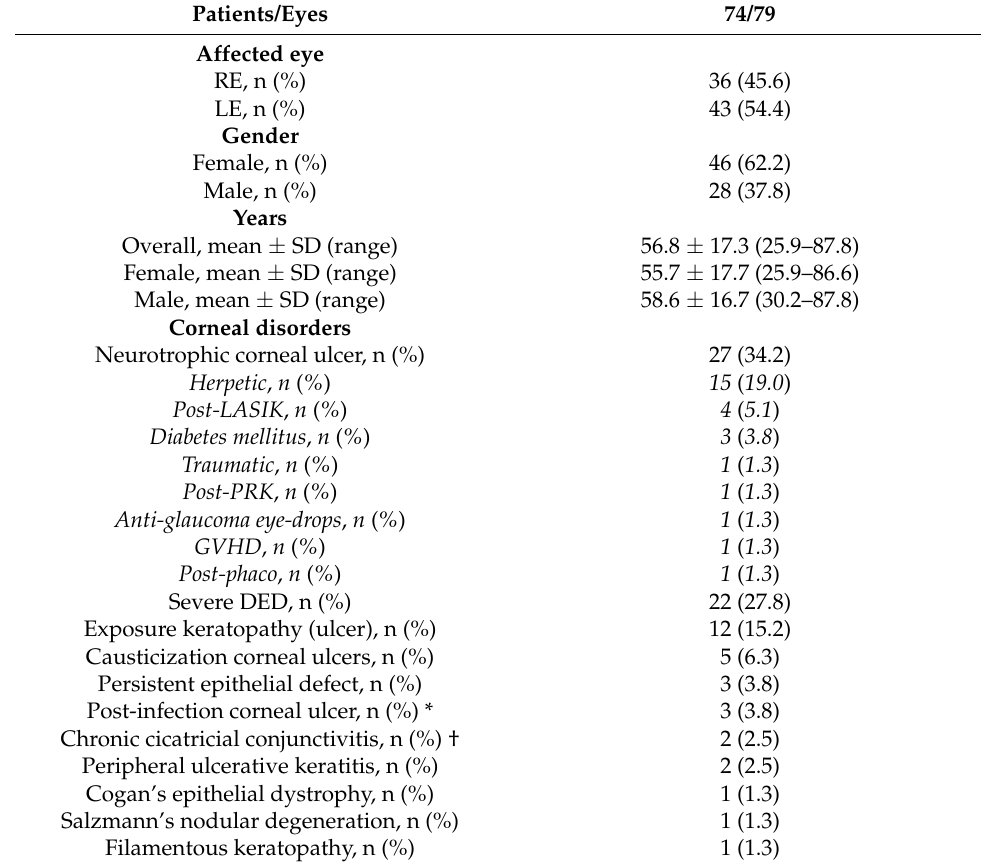
PRGF: Plasma Rich in Growth Factors, RGTA: ReGeneraTing Agent matrix, RE: Right, LE: Left eye, SD: Standard deviation, GVHD: Graft Versus Host Disease, DED: Dry-eye disease. * One eye with persistent ulcer after the resolution of the corneal abscess, two eyes with persistent ulcers after adenovirus infection. † Two eyes (1 patient) with mucous membrane pemphigoid with eye